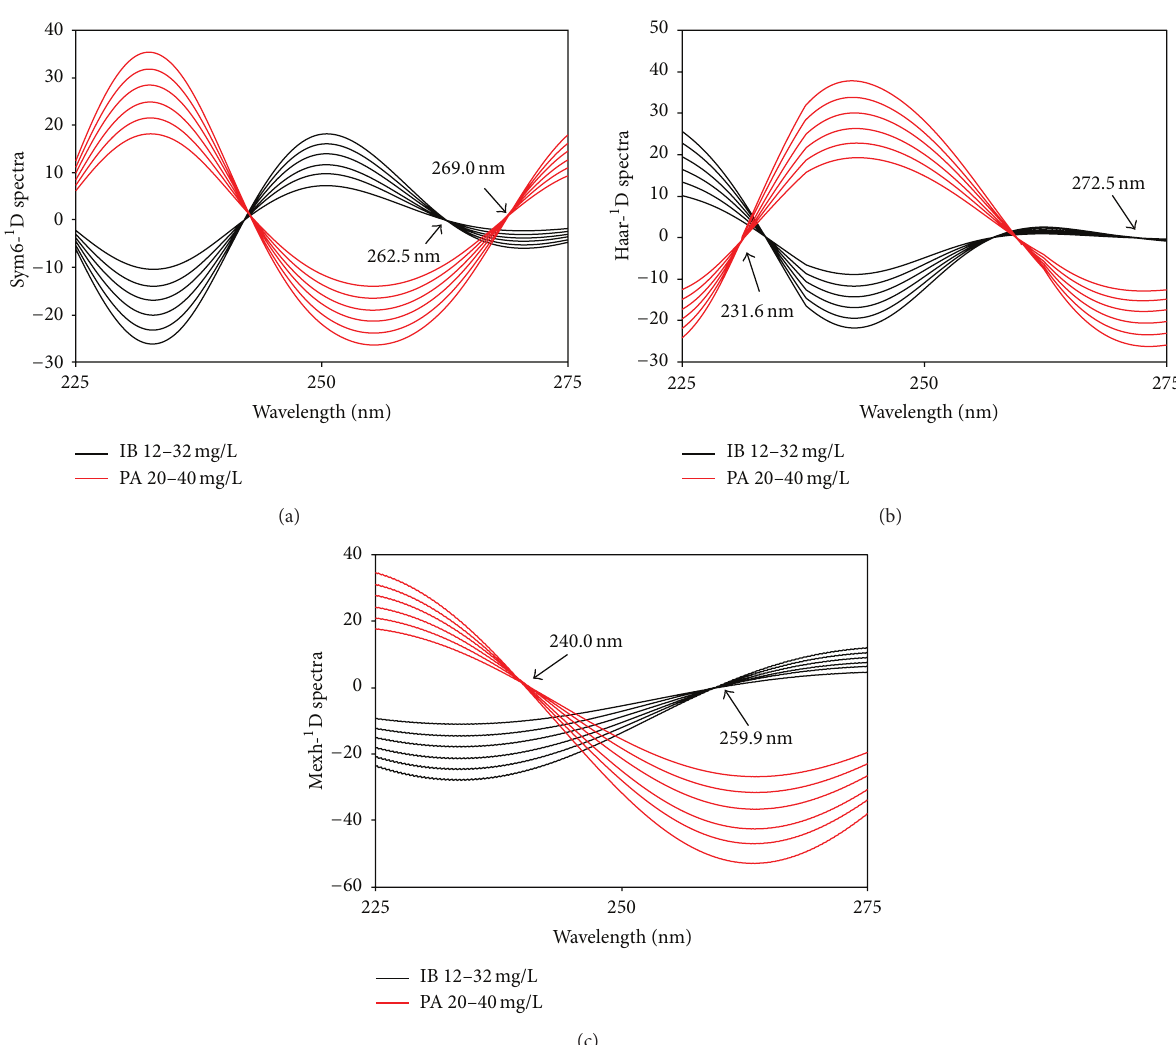
Figure 8: Wavelet transform of first-order derivative spectra using sym6 (a), haar (b), and mexh (c).